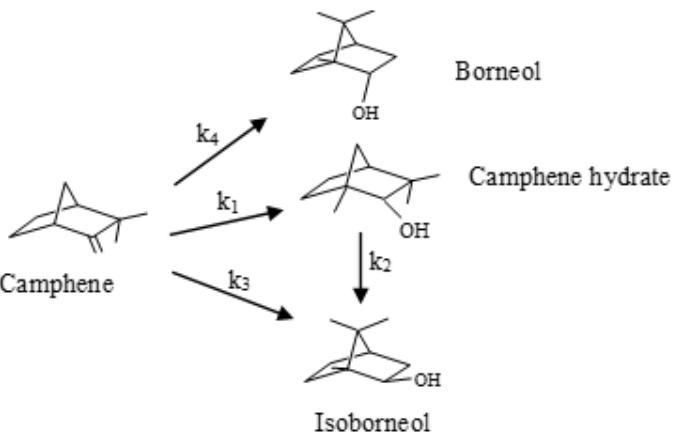
Figure 13. Reaction network used for kinetic modelling in camphene hydration